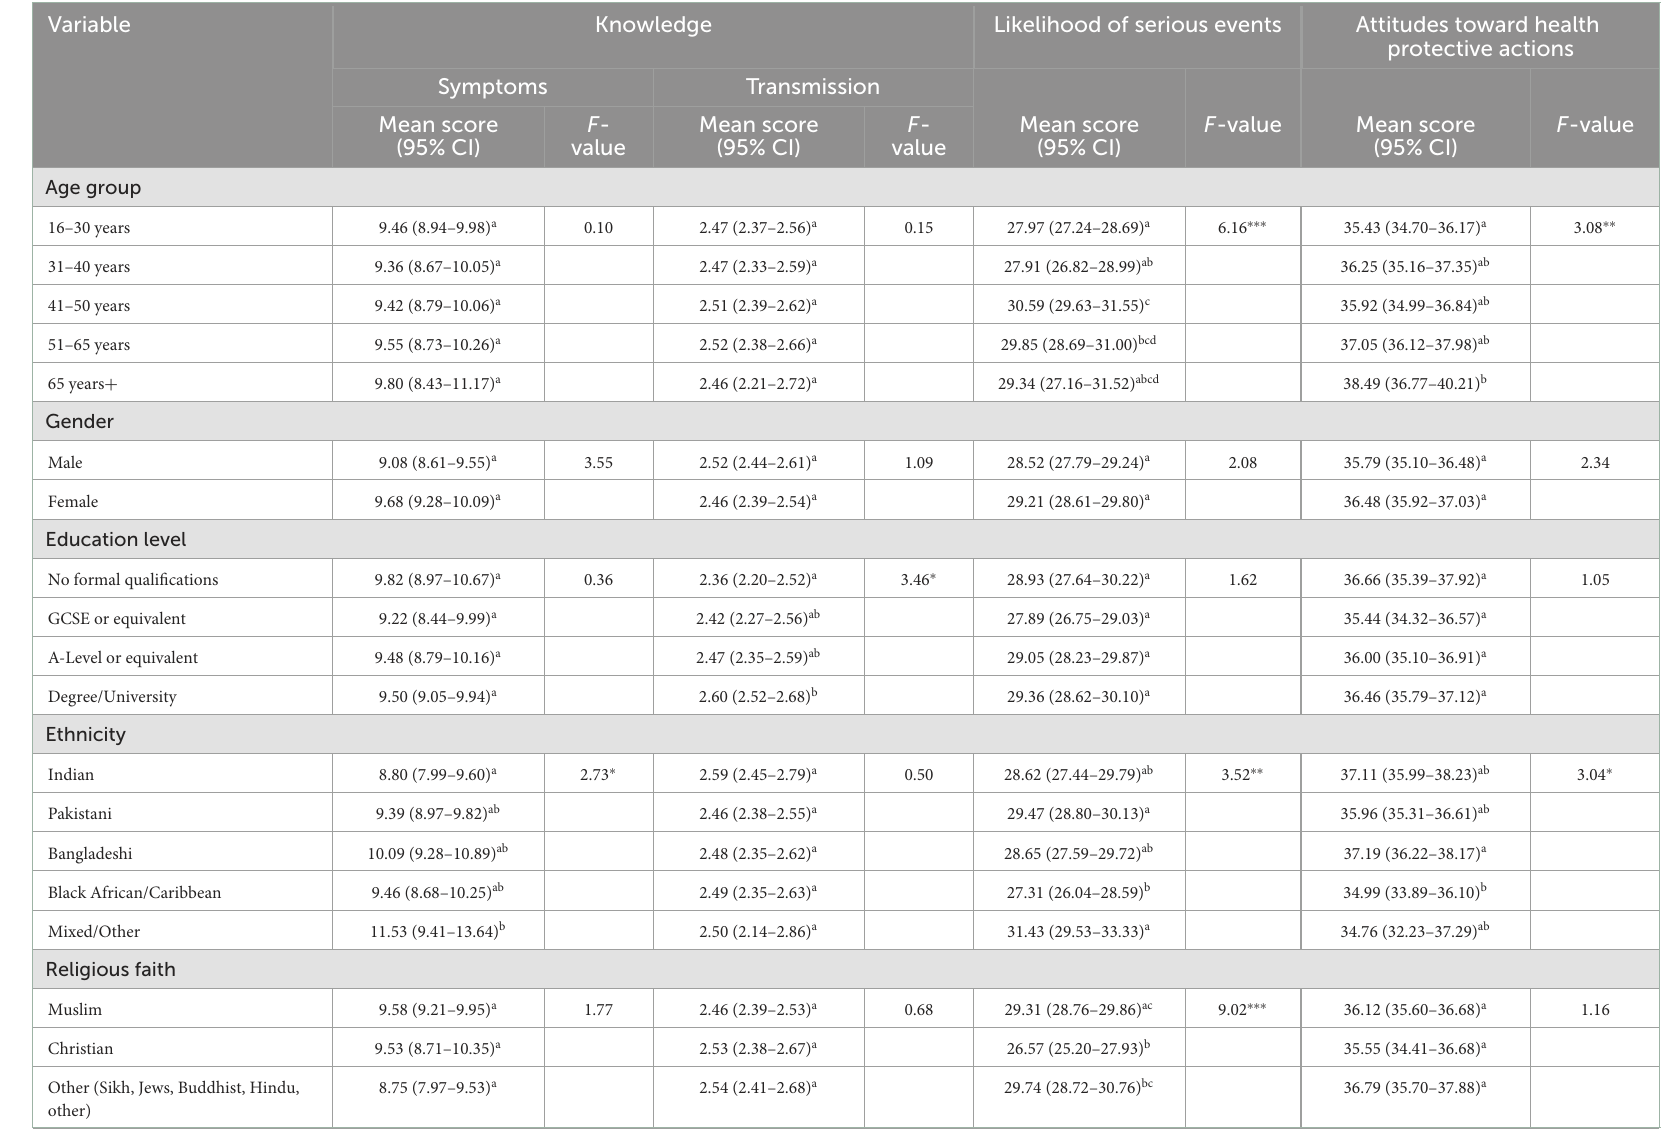
TABLE 2 Univariate Analyses of Variance (ANOVAs) of study variables by socio-demographic and knowledge, perceived risk and attitudes toward health protective actions.